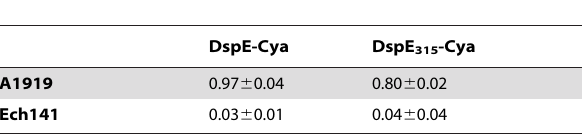
Table 3. Calmodulin-dependent adenylate cyclase activity of Dickeya dadantii strains, A1919 and Ech141, carrying DspE-Cya and DspE 315 -Cya hybrid protein constructs in Nicotiana benthamiana